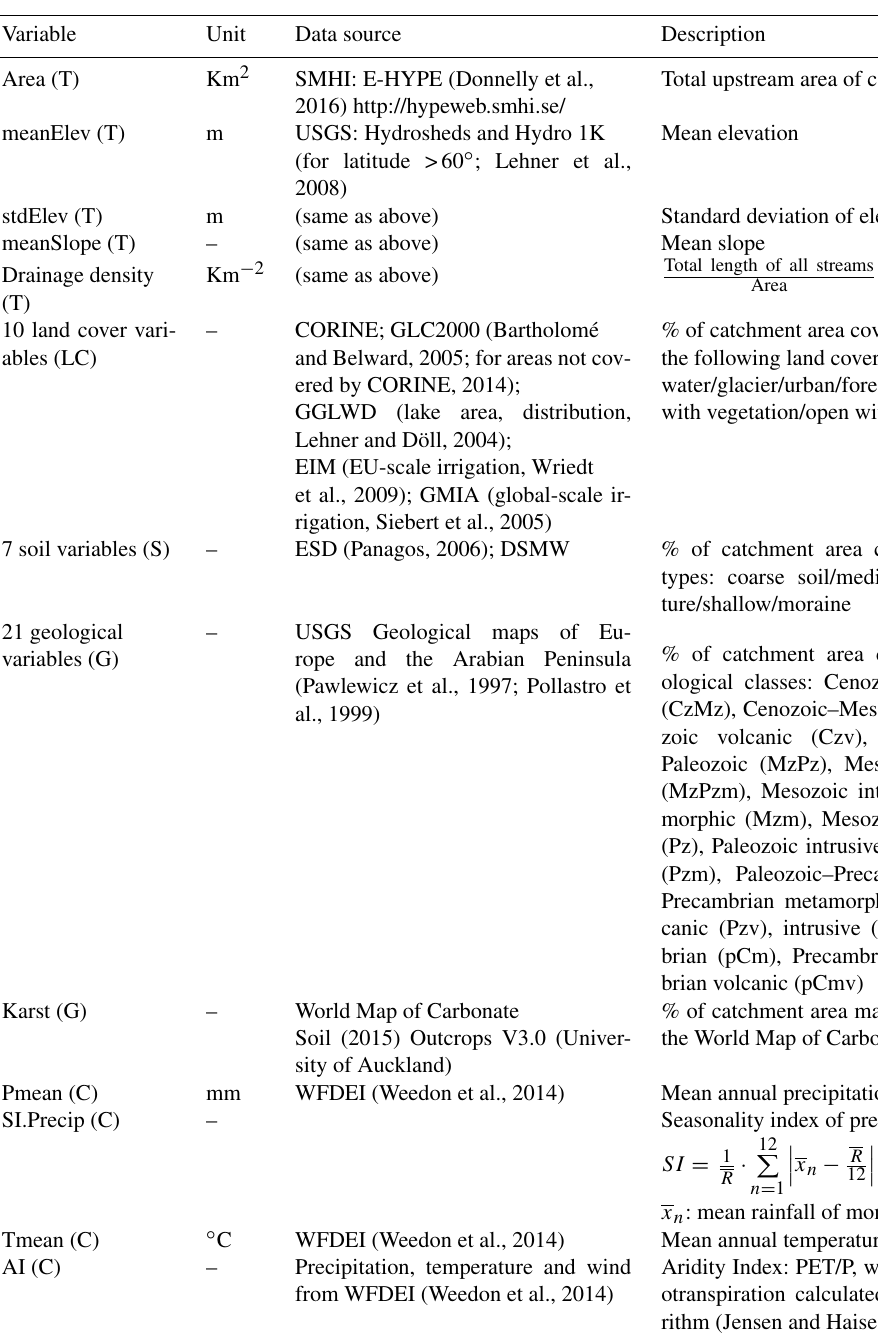
Table 1. Catchment descriptors and the original source of information. Type of descriptor is indicated in brackets after variable name (T: topography; LC: land cover; S: soil type; G: geology; C: climate). Variables marked with grey color were removed from the analysis because no significant correlation was found between these and the flow signatures (see Sect.